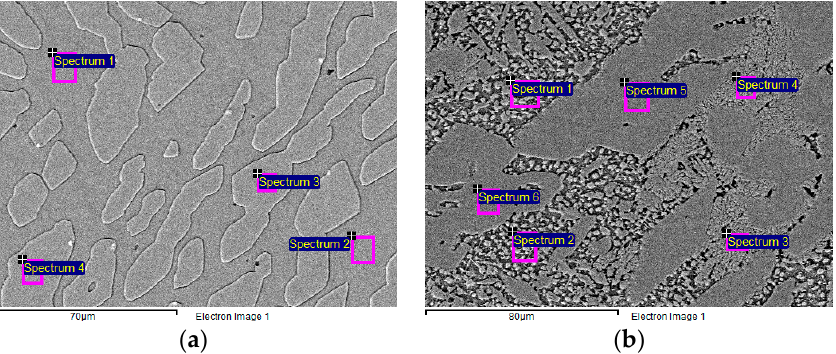
Figure 4. SEM images of ferrite and austenite in: ( a ) Steel 1 after quenching from 1200 °C; ( b ) Steel 4 after provoke annealing at 850 °C for 15 min. Table 4. Chemical composition of phases in DSSs